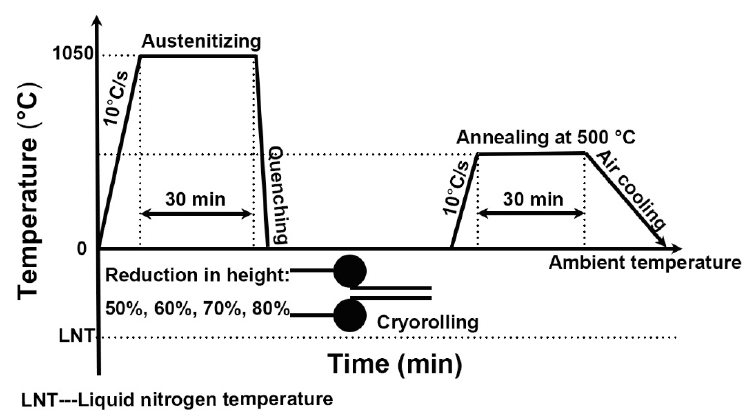
Figure 1. Schematic of fabrication of ultrafine grain by cryorolling low-carbon steel.